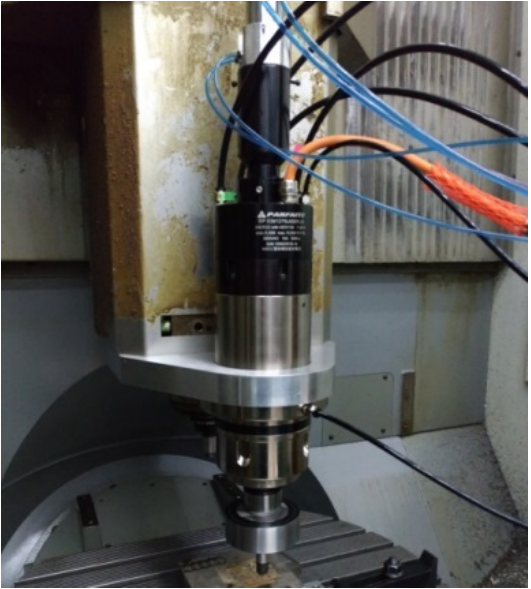
Figure 3. Coaxial laser-assisted spindle of the CNC milling machine.